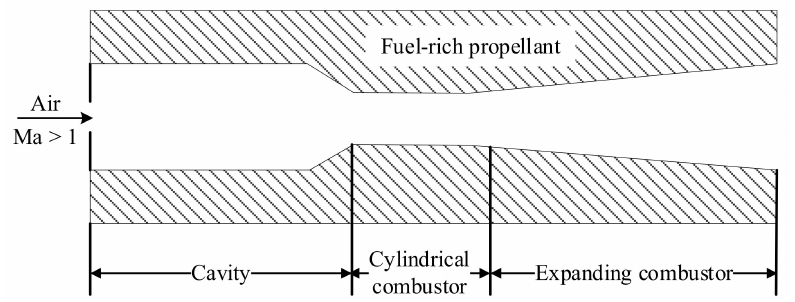
Figure 1. Schematic of a solid scramjet.